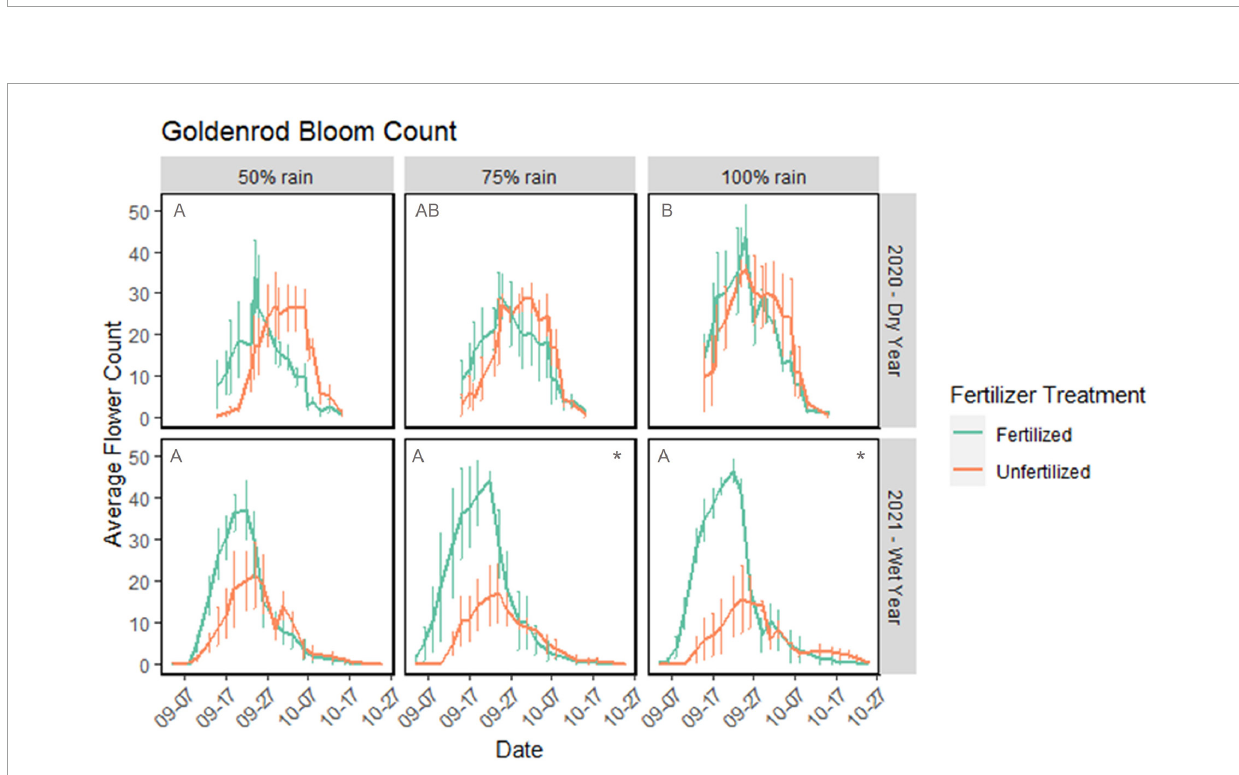
FIGURE4 Average number of flowering units in goldenrod treatments over time in 2020 (dry year) and 2021 (wet year). Number of flowers averaged over three replicate treatments of each rainfall and fertilizer treatment. Each replicate contained approximately 12 plants. Fertilized treatments in green and unfertilized in orange. Each *represents statistical difference ( p < 0.05) in total flowers produced between fertilized vs. unfertilized plants. Letters represent difference in flower production between rainfall treatments within a given year (row). Error bars represent standard